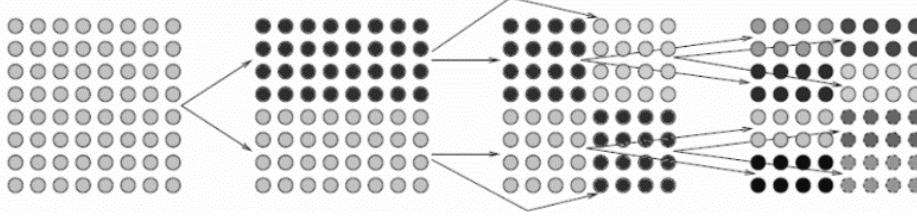
Figure 3. Recursive bisection group tree structure of index set.